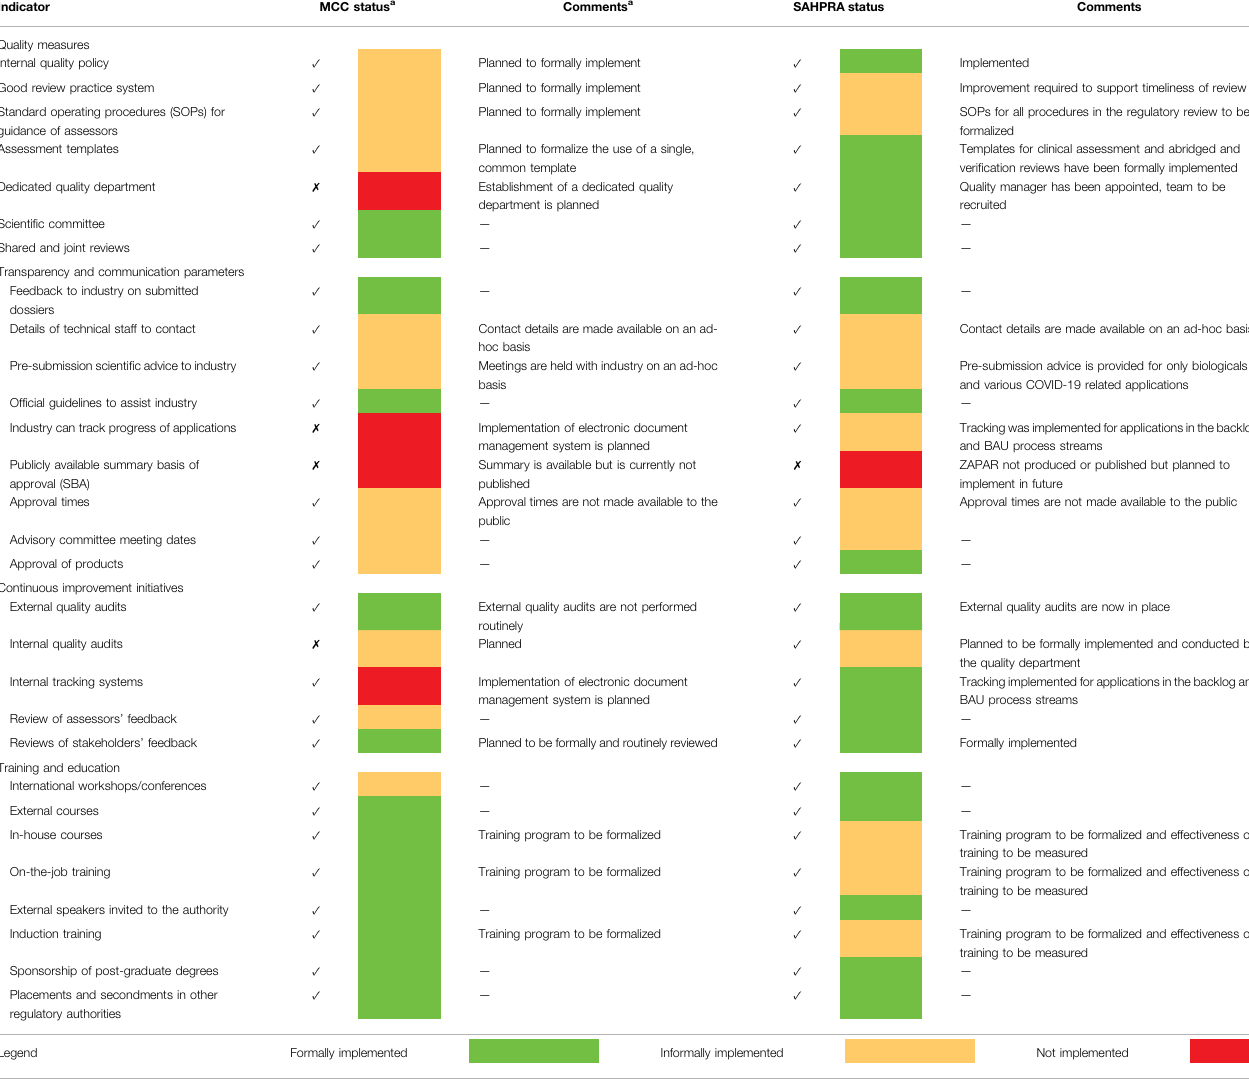
TABLE 4 | Status of implementation of good review practices by